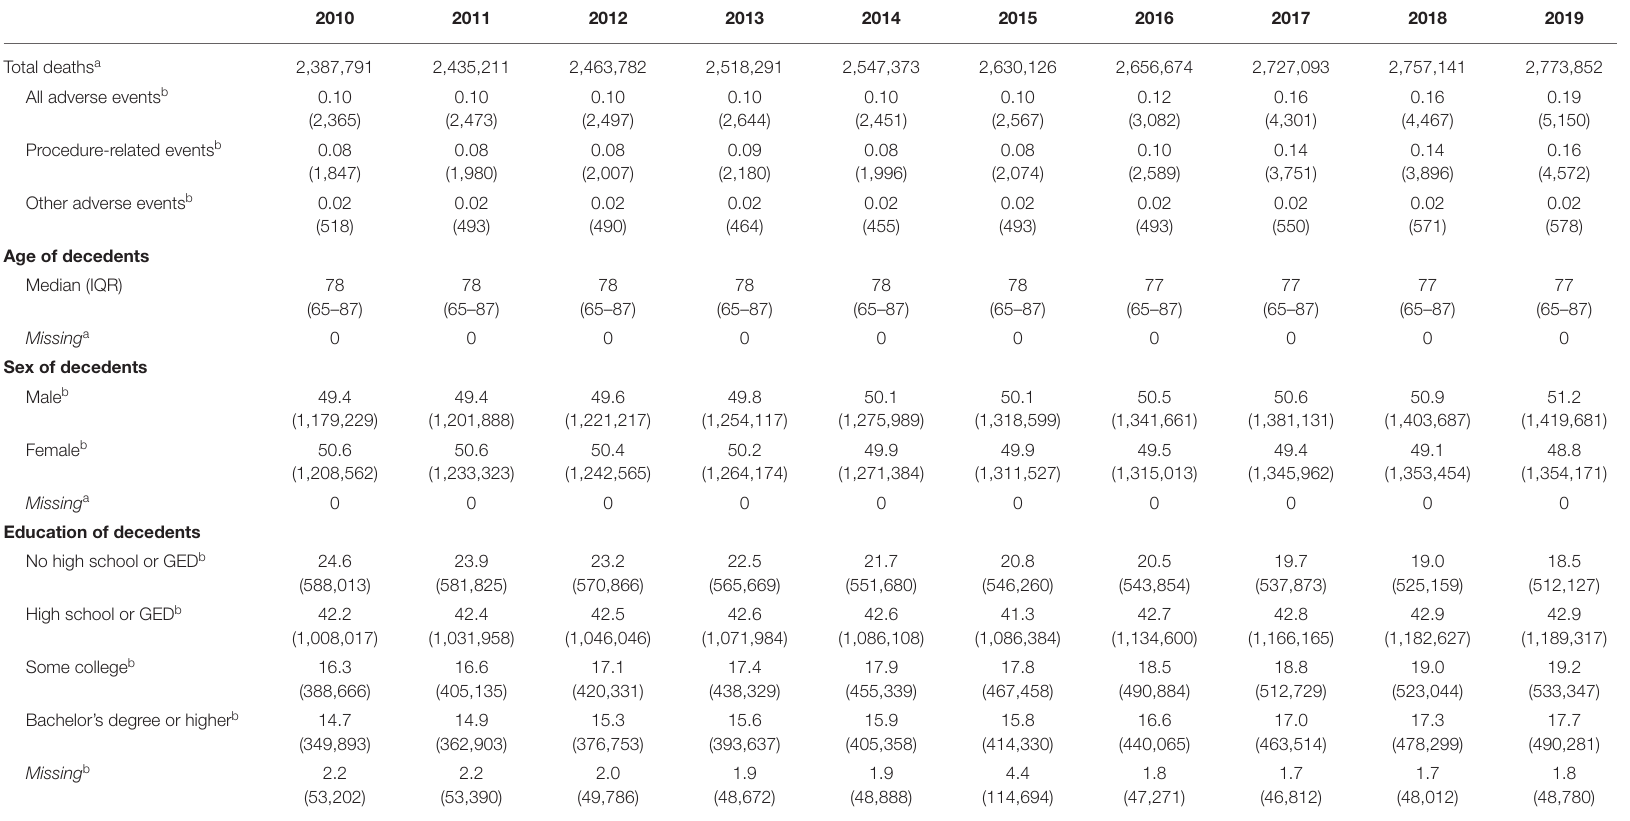
TABLE 2 | General characteristics of the decedents. The dataset comprised ≥ 30-year-old